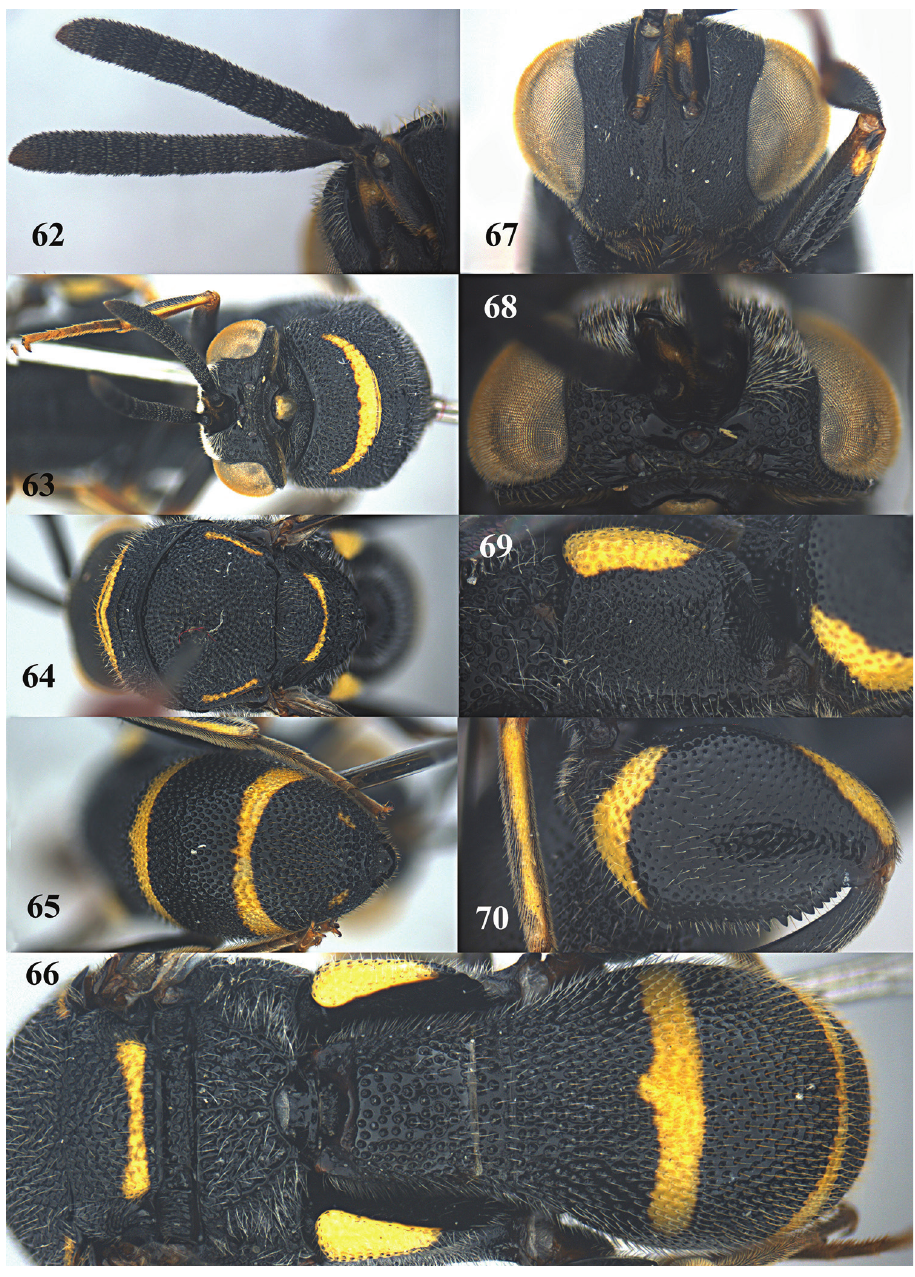
Figures 62–70. Leucospis femoricincta Bouček, ♂ from Guangdong, Yingxifenglin. 62 Antennae 63 head and pronotum dorsal 64 mesosoma dorsal 65 metasoma postero-dorsal 66 propodeum and metasoma dorsal 67 head frontal 68 head dorsal 69 hind coxa 70 hind